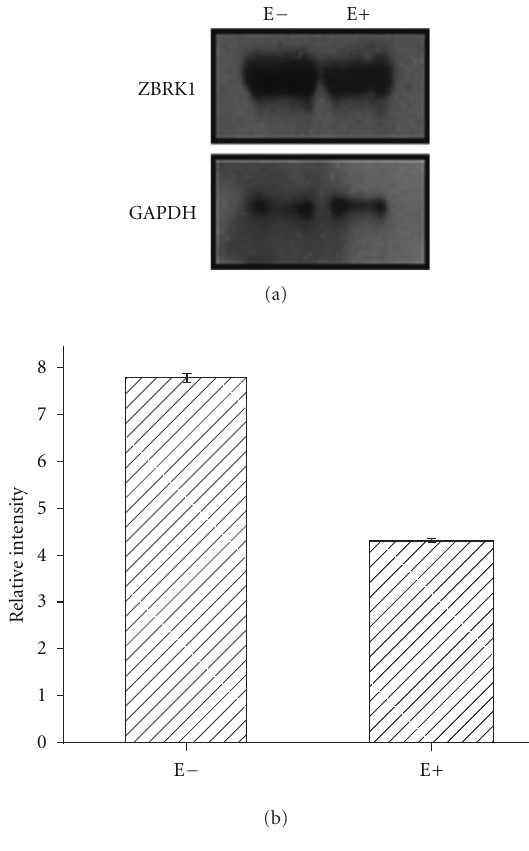
Figure 4: (a) Western blot of ZBRK1 in endothelial cells of estrogen receptor negative (E − ) and estrogen receptor positive (E+) breast cancer tissues. (b) Bar diagram showing the relative intensity of ZBRK1 in estrogen receptor negative (E − ) and positive (E+) tissues as compared the GAPDH control. ImageJ software was used for densitometric analysis and error bars represents standard